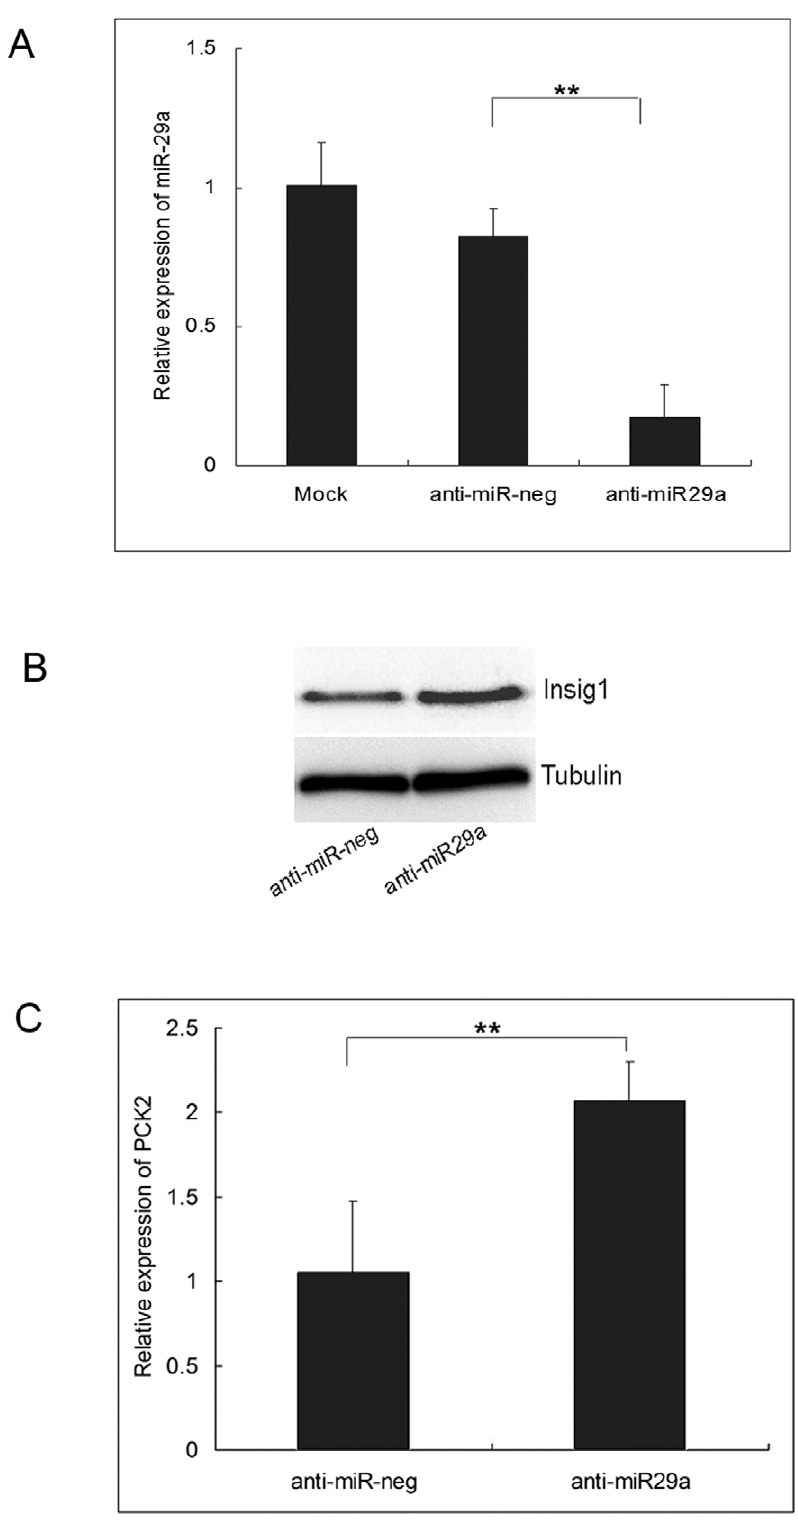
Figure 2. Expression of miR-29a in HepG2 cells transfected with 100 nM anti-miR-29a, anti-miR-neg or mock to determine the knockdown efficiency of anti-miR-29a. ** P , 0.01. B. Western blots for Insig1 or tubulin using protein extracts from HepG2 cells transfected with 100 nM anti-miR- 29a or anti-miR-neg. C. Expression of PCK2 in HepG2 cells transfected with 100 nM anti-miR-29a, anti-miR-neg to determine the regulation of miR-29a on the expression of PCK2. Data represented three independent experiments 6 S.E.M. with n=3. ** P , 0.01.